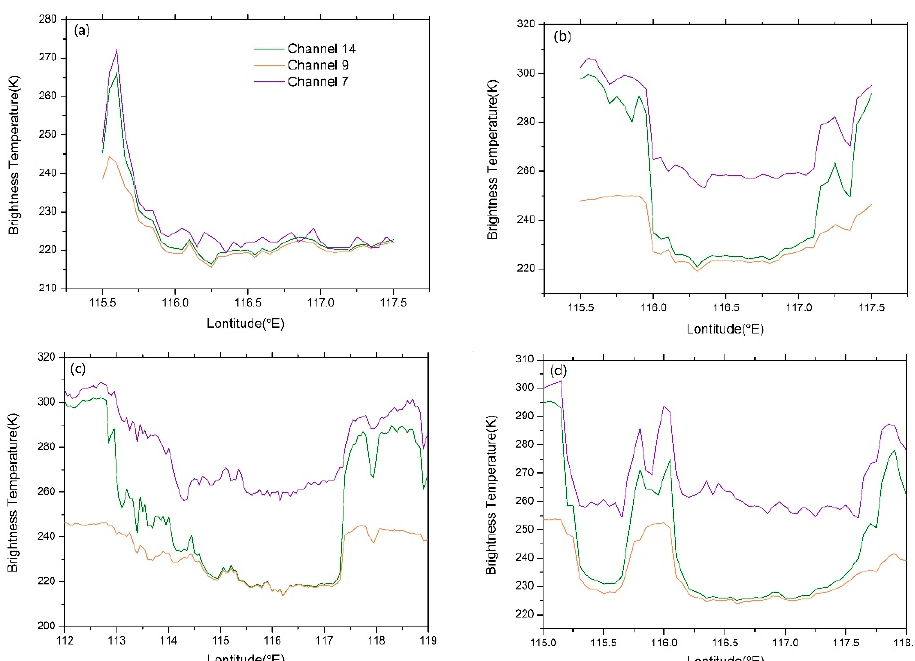
Figure 10. Brightness temperature (BT) distribution (channel 7: violet line; channel 9: orange line; channel 14: olive line) along transects (40.5 ◦ N) crossing the main core of the hailstorm in the longitudinal direction for the analyzed case studies. ( a ) BT at 20:00 BJT on 25 June 2021; ( b ) BT at 16:00 BJT on 30 June 2021; ( c ) BT at 16:00 BJT on 1 July 2021; ( d ) BT at 17:00 BJT on 9 August 2021.